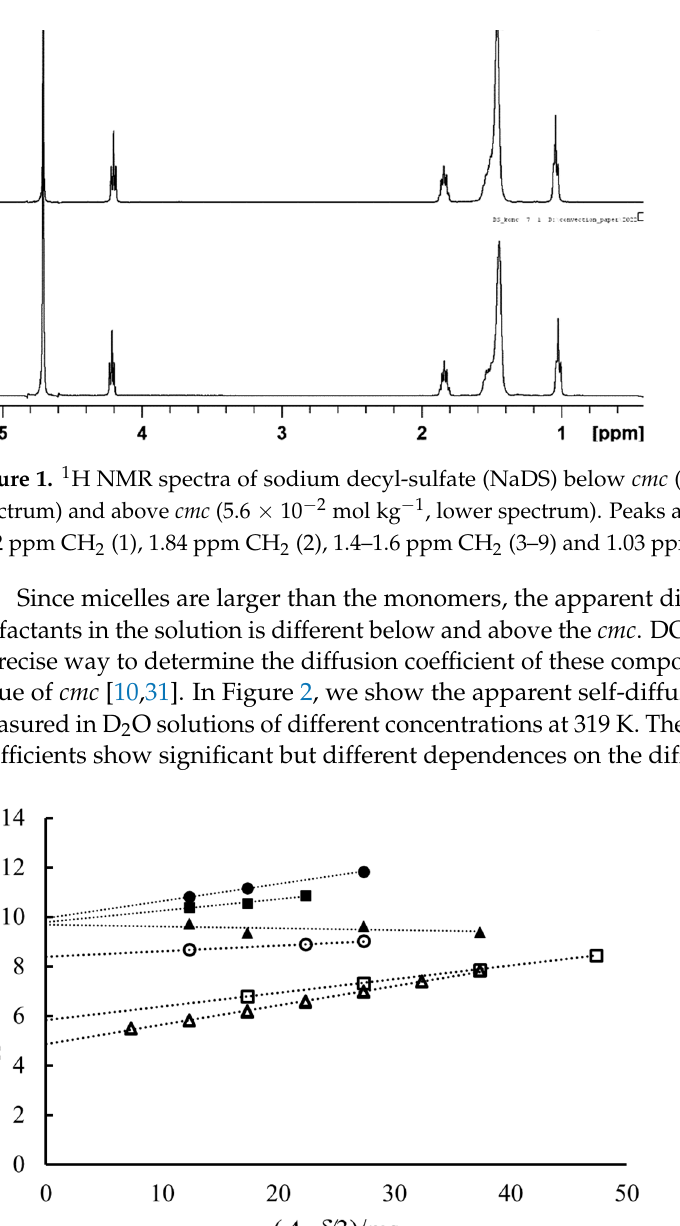
Figure 2. The apparent self-diffusion coefficients measured at different concentrations as a function of the diffusion time ( Δ ) at 319 K. Concentrations: ▲ 0.005 mol kg − 1 , ● 0.015 mol kg − 1 , ■ 0.029 mol kg − 1 , ○ 0.047 mol kg − 1 , □ 0.059 mol kg − 1 , Δ 0.074 mol kg − 1. The intercepts of the curves show the expected tendency with the concentration. Un-